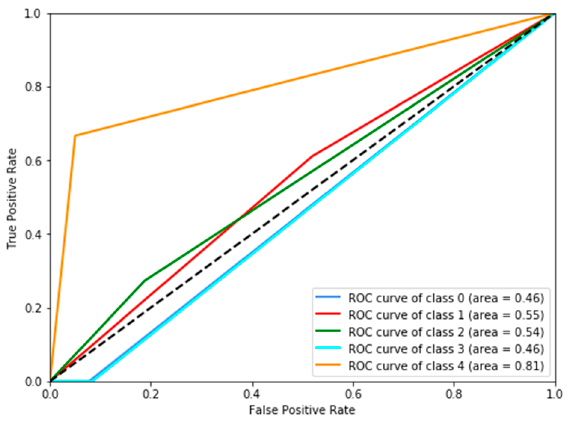
Figure 10. Per-class AUC of PMFE-SN.